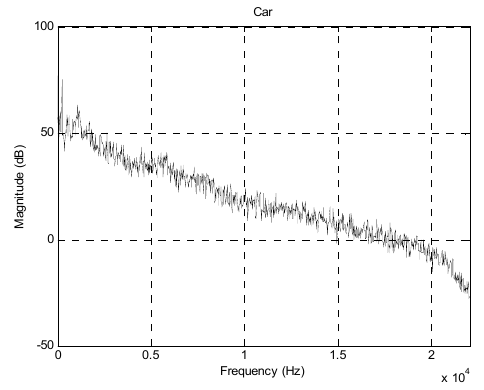
Figure 10. Spectrum of an